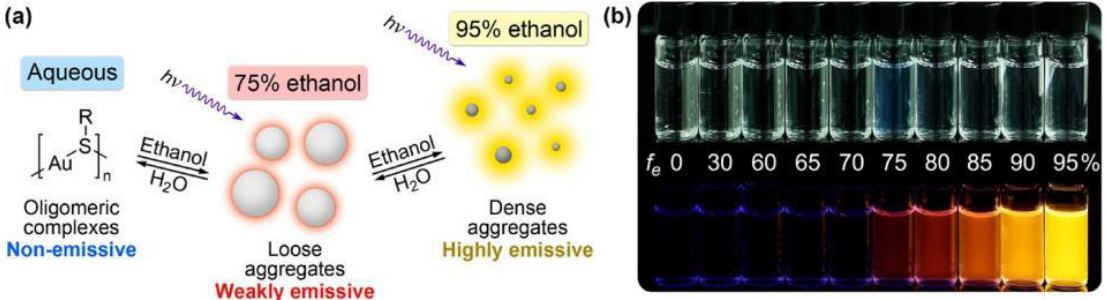
Figure 15. Solvent-induced Au–thiolate complexes aggregation-induced emission (AIE) phenomenon. ( a ) Schematic diagram of solvent-induced AIE properties of Au(I) − thiolate complexes. ( b ) Digital photos of Au(I)−thiolate complexes in different fraction of ethanol under visible (top row) and UV (bottom row) light. Reprinted with permission from Ref. [150]. Copyright © 2012 American Chemical Society.